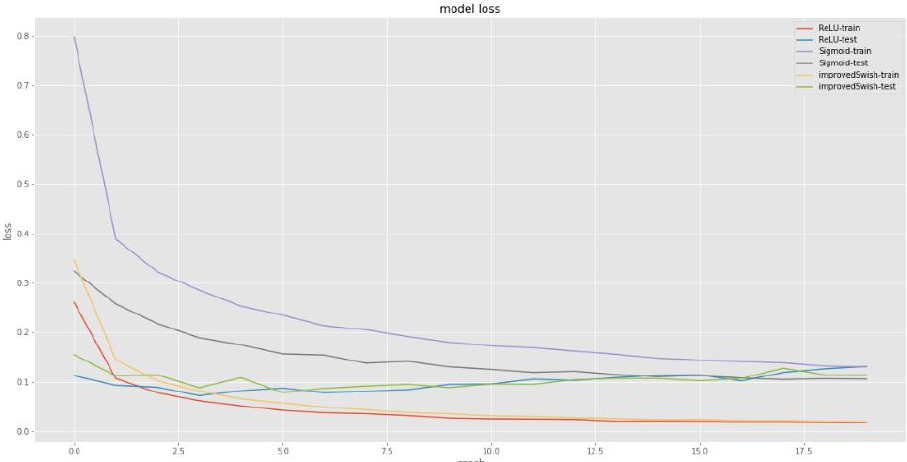
Figure 1. Comparison of loss. The horizontal axis represents epoch times (0~17.5), and the vertical axis represents loss value (0~0.8).